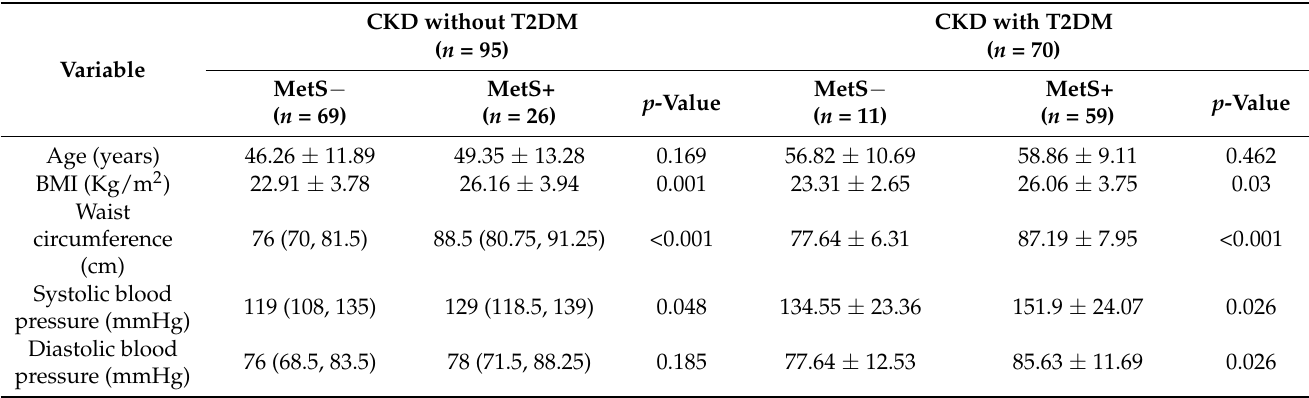
Table 2. Comparison of clinical characteristics of female patients according to the Chinese Guidelines for the Prevention and Treatment of Type 2 Diabetes (2020